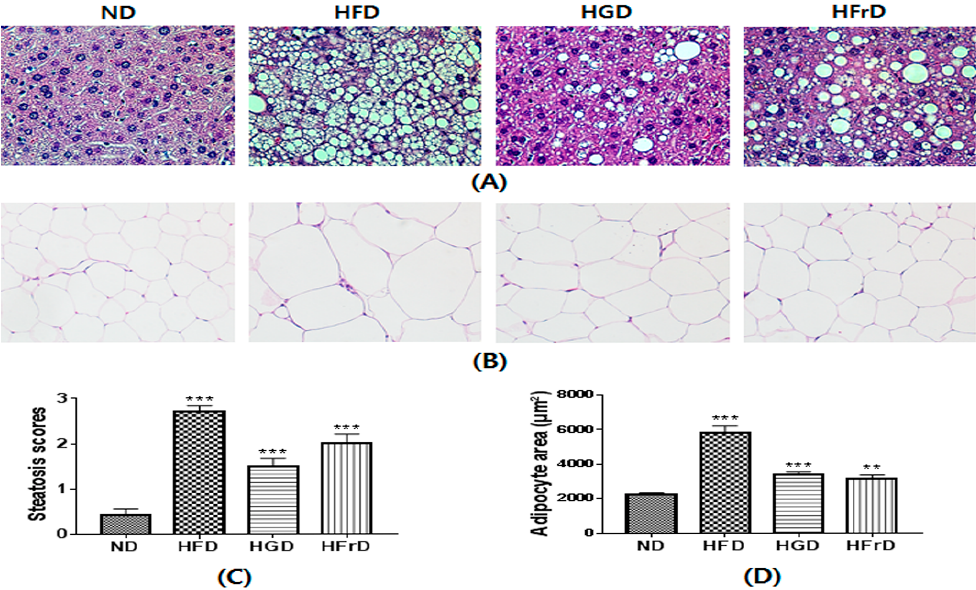
Figure 6. HFD, HGD or HFrD-induced hepatic steatosis and adipocyte hypertrophy. ( A , B ) representative histological results of liver and WAT by hematoxylin and eosin staining; ( C ) steatosis score of liver; ( D ) quantification of adipocyte area. Values are expressed as means ± SEM for 3 mice per group (** p < 0.01, and *** p < 0.001 vs. ND).